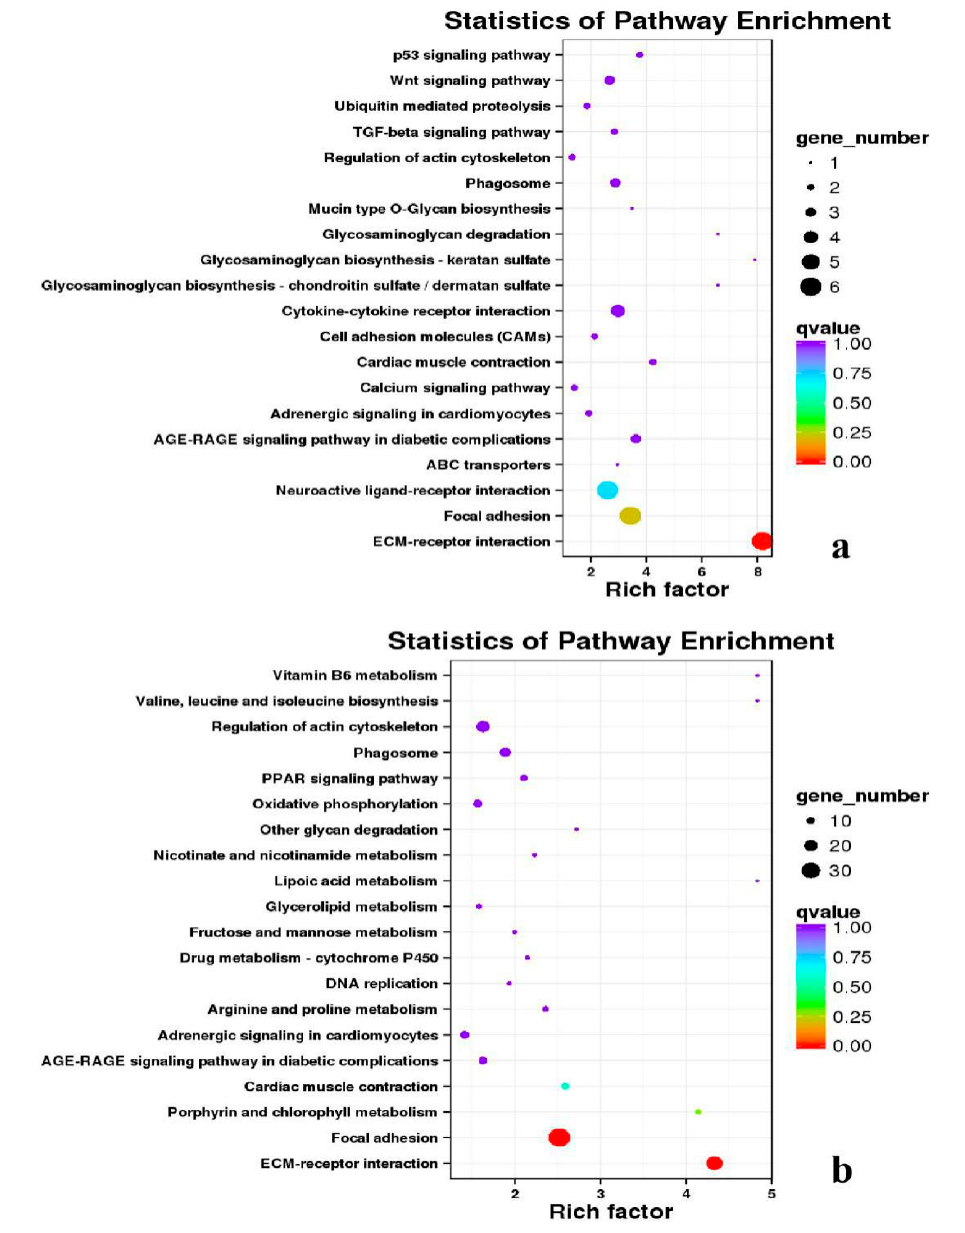
Figure 18. KEGG annotation of DEGs in the comparison of breast and leg muscle. ( a ) BE17B_vs_BE17L; ( b ) BE21B_vs_BE21L.